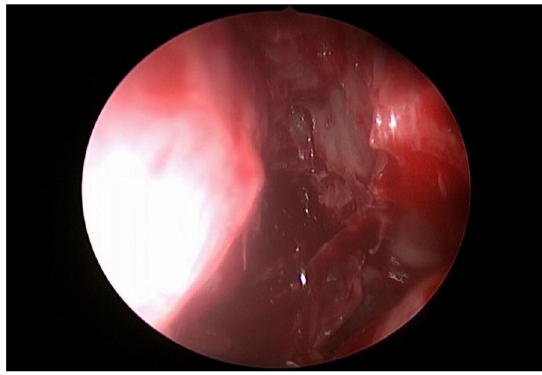
Fig. 1 Anterior ethmoidectomy without frontal ostium identification